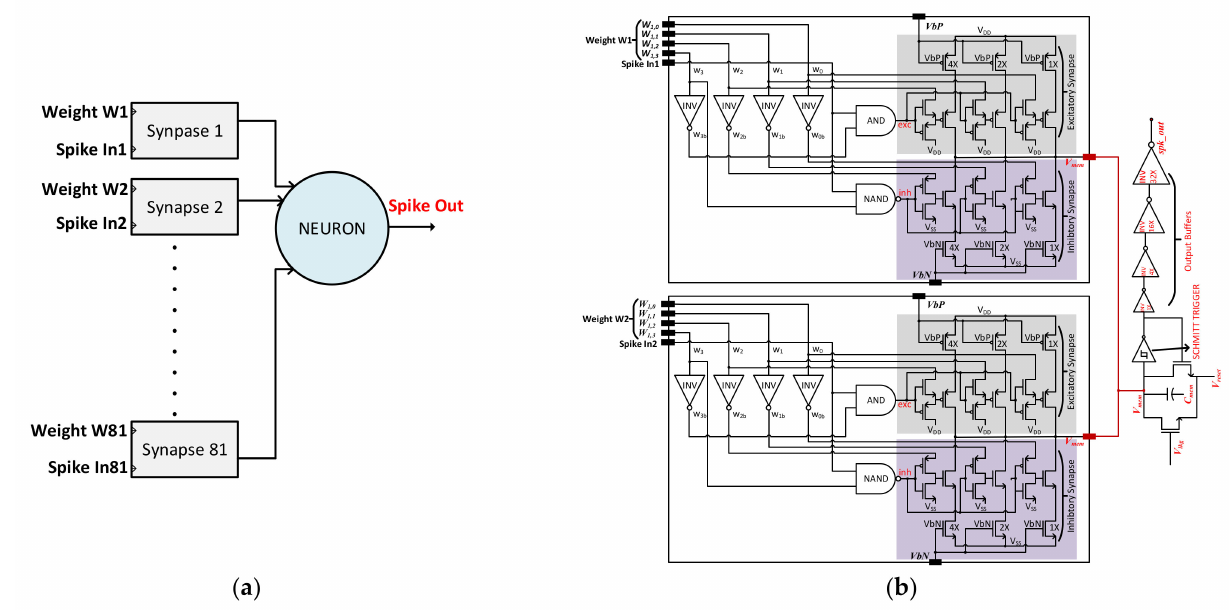
Figure 6. ( a ) Fully connected hidden layer with a large number of synapses connected to a single neuron; ( b ) One neuron cell of the hidden layers with two synapses connected to a single neuron.